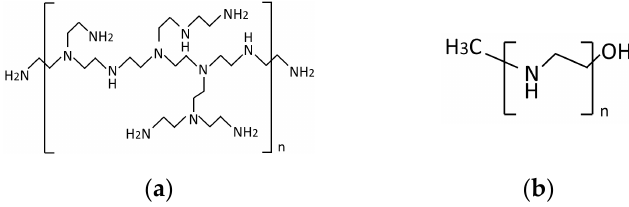
Figure 1. ( a ) Branched polyethylenimine molecule [33], and ( b ) lineal polyethylenimine molecule [34] .